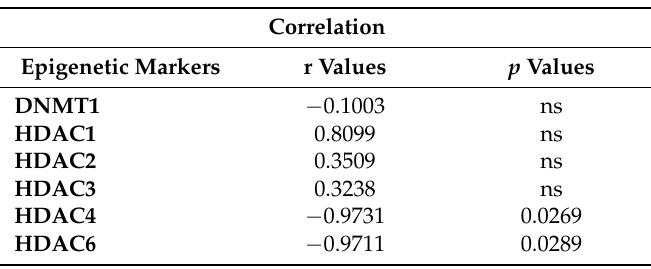
Figure 2. Differential expression of DNA methyltransferases (DNMT)1 and histone deacetylases (HDACs) in breast cancer cells. ( A ) Immunoblotting of DNMT1 and different HDACs in MCF7, SkBr3, BT-549 and MDA-MB-231. DNMT1 and HDAC1 were visualized on the same blot, HDAC2, HDAC6 and phospho- HDAC4,5 and 7 were visualized on another blot whereas HDAC3 and 4 were visualized on a third blot ( B ) Quantification of band intensities of the indicated proteins. Each protein visualized on a blot was normalized to the corresponding β -actin as a loading control. ( C ) Correlations between the expression levels of ER α and HER2 and the expression levels of DNMT1, HDAC1, HDAC2, HDAC3, HDAC4 and HDAC6 in the indicated cell lines. Shown are the means ± SEM of at least three independent experiments. * p < 0.05 versus MCF7 cells, # p < 0.05 versus SkBr3 cells and & p < 0.05 versus BT-549 cells. Abbreviation: ns, not significant. Table 2. Statistical parameters of correlation analysis between the expression levels of ER α and HER2 and the expression levels of epigenetic markers.